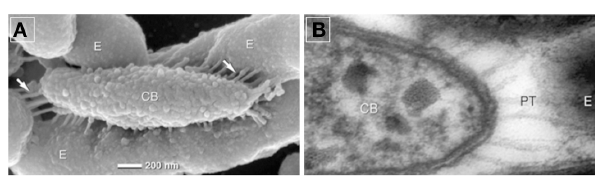
FIGURE 3 | (A) Scanning electron photomicrographs of a partially disaggregated consortium, E, epibiont, CB, central bacterium, arrows pointing toward periplasmic tubules (PT). (B) Transmission electron photomicrographs of ultra-thin sections showing elongated PT at the tip of the central bacterium. Modified afterWanner et al. (2008).